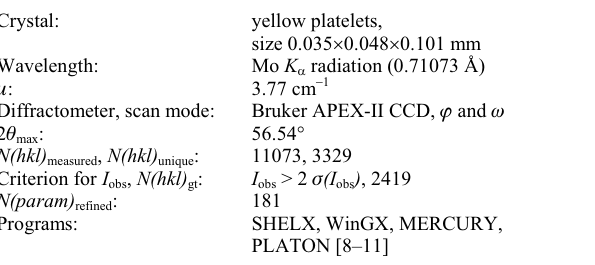
Table 1. Data collection and handling.